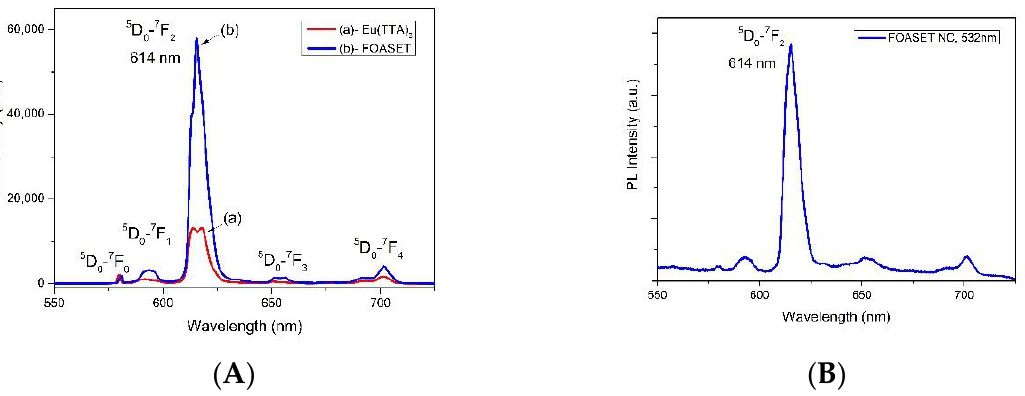
Figure 9. ( A ) Luminescent spectra of (a) FOASET nanoparticles and (b) Eu(TTA) 3 complex under excitation at λ exc = 355 nm and ( B ) at λ exc = 532 nm.